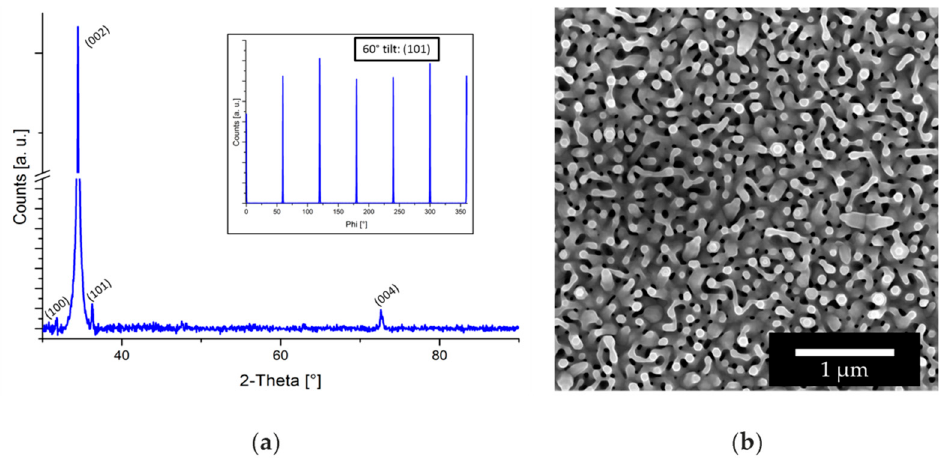
Figure 3. 100 nm thick ZnO thin film on Al 2 O 3 . ( a ) Grazing incidence theta-2-theta X-ray diffraction reveals a strong (001) out-of-plane texture. The phi scan in the inset reveals (101) 6-fold symmetry as expected from a single crystal. ( b ) SEM image of the surface of the thin film showing high roughness at ca. 100 nm length scale.